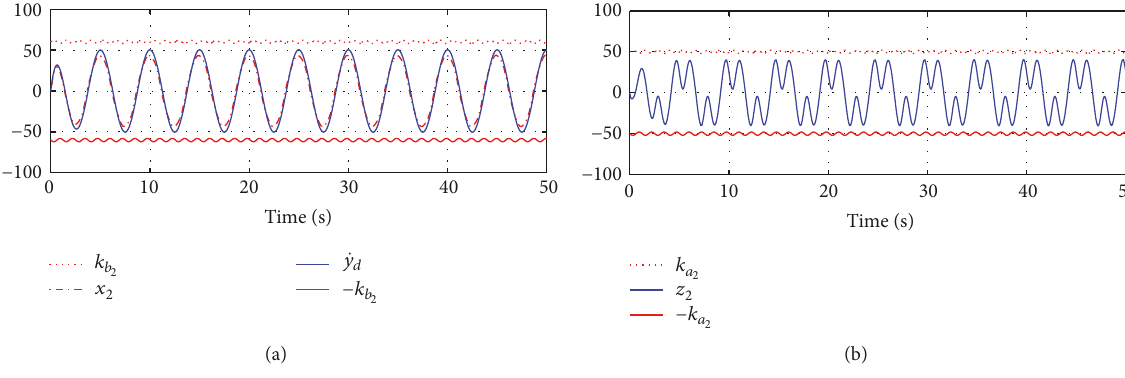
Figure 2: (a) Trajectories of 𝑥 2 (dashed) and ̇𝑦 𝑑 (solid); (b) the trajectory of tracking error 𝑧 2